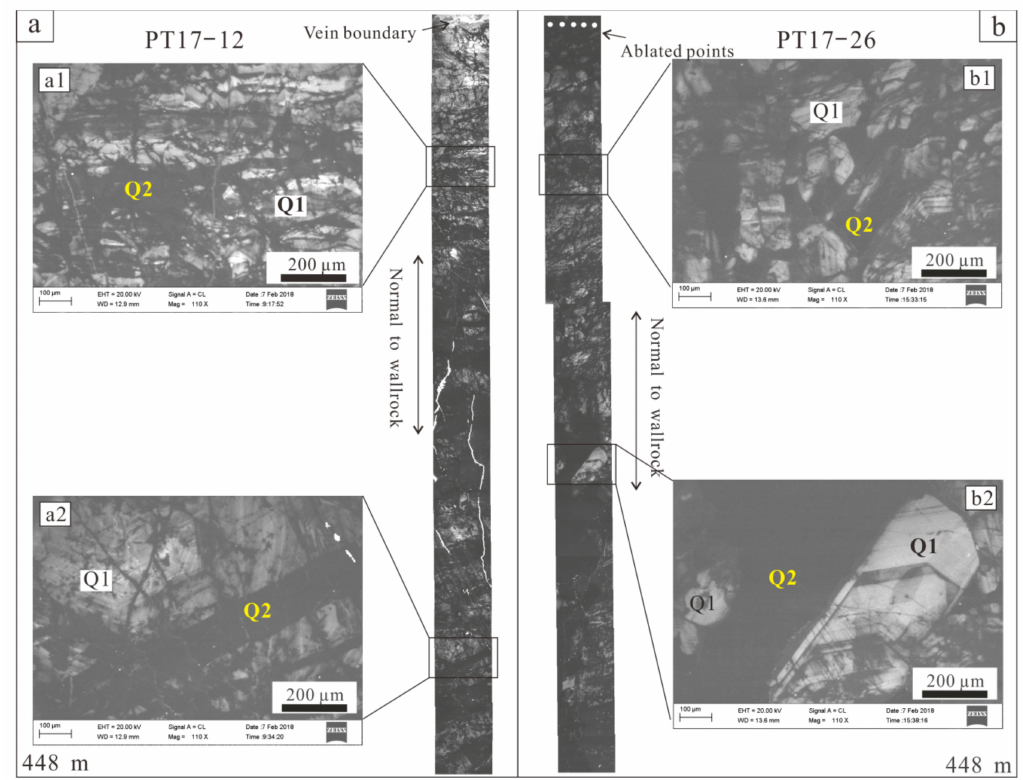
Figure 12. Composite SEM–CL panchromatic images of the samples PT17-12 ( a ) and PT17-26 ( b ) at the 448 m level. Two generations of quartz were identified from the SEM–CL images. The early CL–bright generation of quartz (Q1) is crosscut by the second CL–dark generation of quartz (Q2). The euhedral CL–bright quartz in Figure 12(b2) is interpreted to belong to the first generation of quartz Q1 rather than another generation of quartz for two reasons. The first reason is that the growth zones of this euhedral quartz look similar to other CL images of quartz at the same level. The second reason is that this euhedral quartz is almost covered by Q2, indicating that this euhedral quartz may precede Q2.